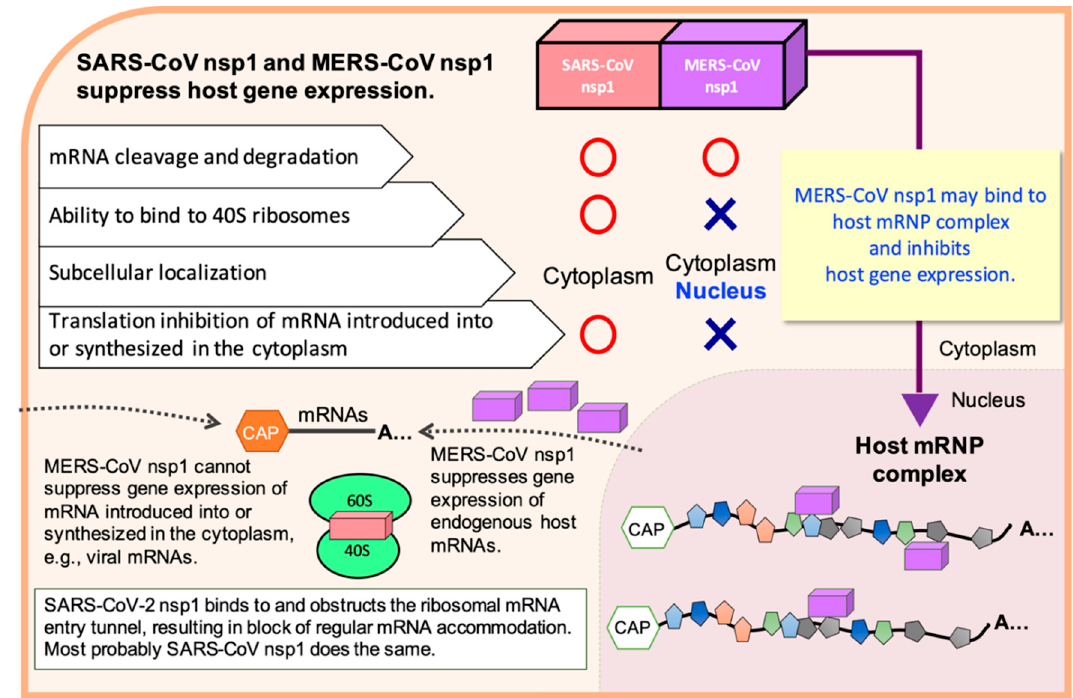
Figure 3. Biological properties of SARS-CoV nsp1, MERS-CoV nsp1, and SARS-CoV-2 nsp1 for inhibiting host gene expression and a possible mechanism of the MERS-CoV nsp1-mediated inhibition of host gene expression. It has been suspected that SARS-CoV nsp1 and MERS-CoV nsp1 recruit a cellular endonuclease to induce endonucleolytic RNA cleavage in host mRNAs, leading to accelerated mRNA degradation.